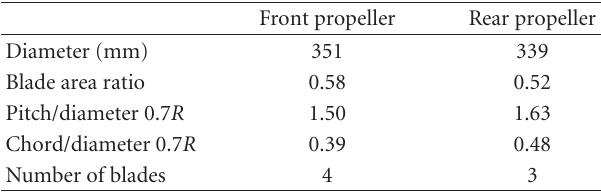
Table 1: Characteristics of CR propellers experimentally